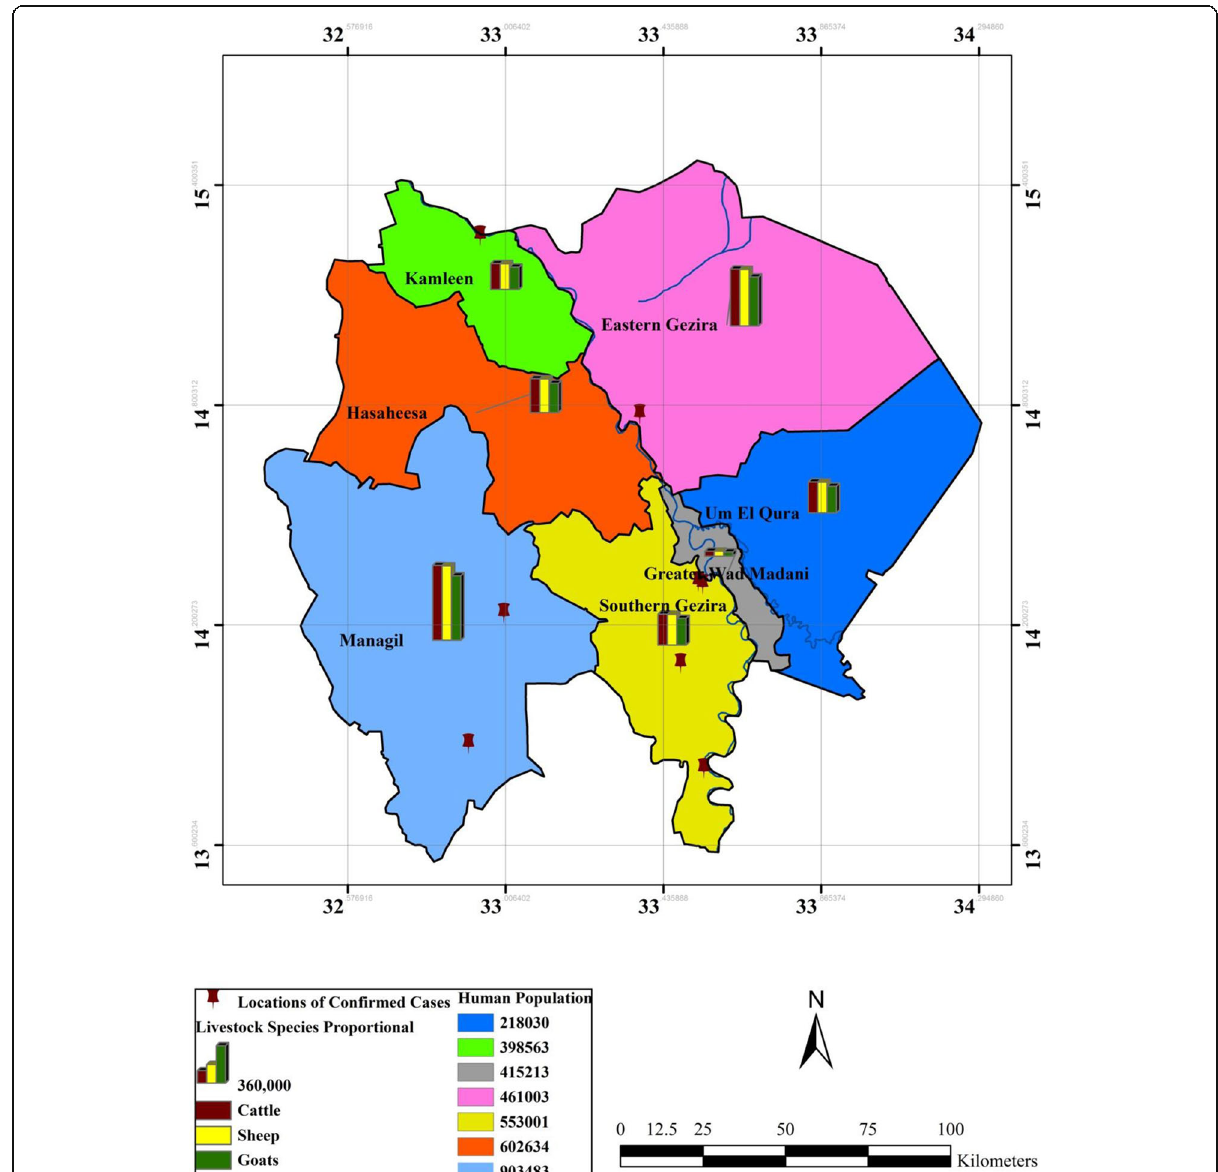
Fig. 2 Spatial distribution of RVF human confirmed cases among Gezira state localities and the related animal population as a proportional bar column chart and human